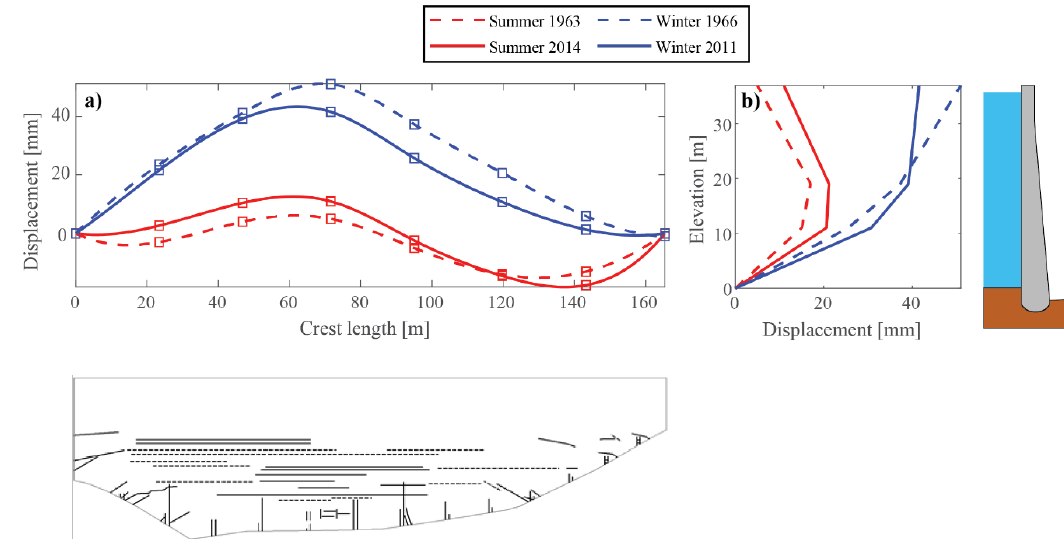
Figure 3. Measured displacement of the dam, shortly after finalisation (dashed lines) and after about 50 years of service (solid lines) for summer (red) and winter (blue) conditions, respectively, ( a ) crest displacement, ( b ) displacement along the dam height. The figure also shows the observed crack pattern on the downstream side ( bottom ) and the cross-section of the dam ( right